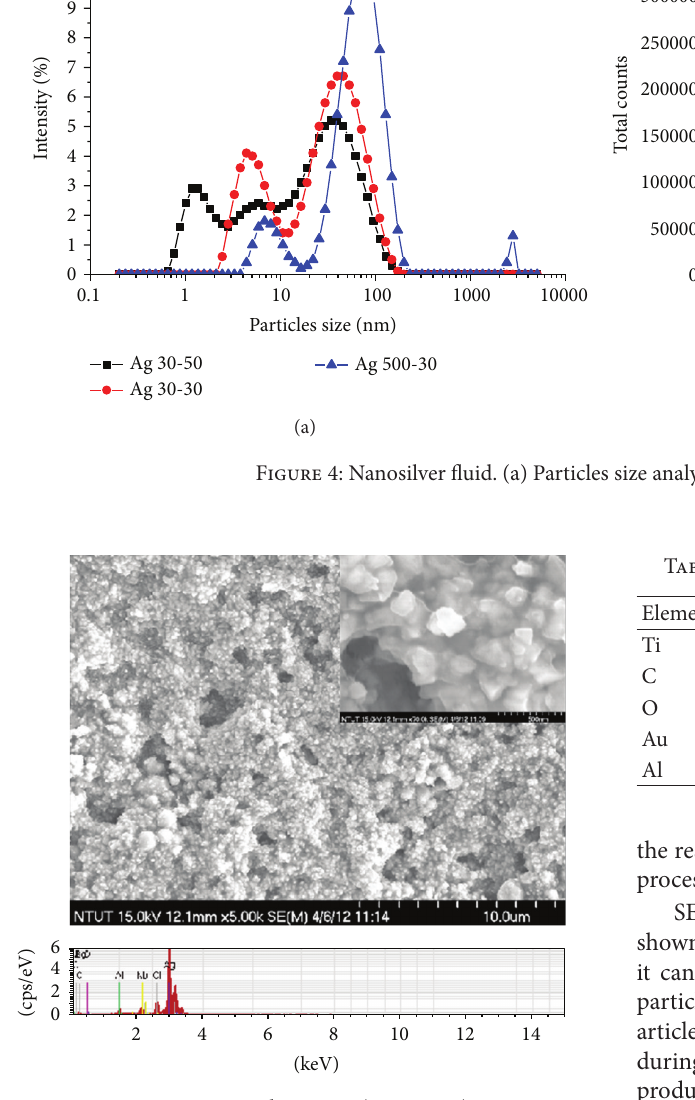
Figure 5: Nano silver, SEM (SEM-EDX).